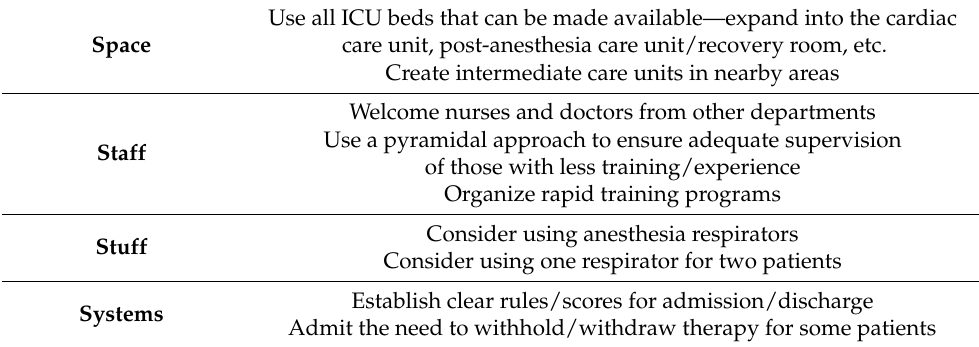
Table 1. Some methods used to try and cope with the shortage of ICU